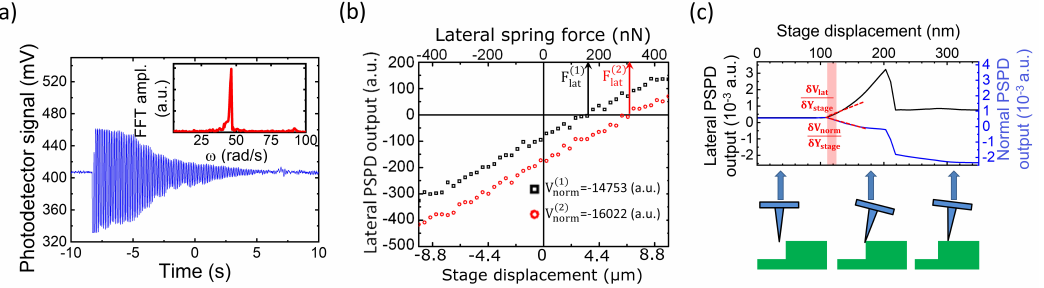
Figure 4. Three-step calibration procedure. At first, the free vibration of the magnetically levitated spring was recorded ( a ) to determine the resonant angular frequency by FFT (a inset). The lateral force acting on the probe was calibrated by the magnetic spring ( b ). Finally, the lateral (torsional) spring constant of the cantilever was evaluated by scanning a rigid rectangular step ( c ).